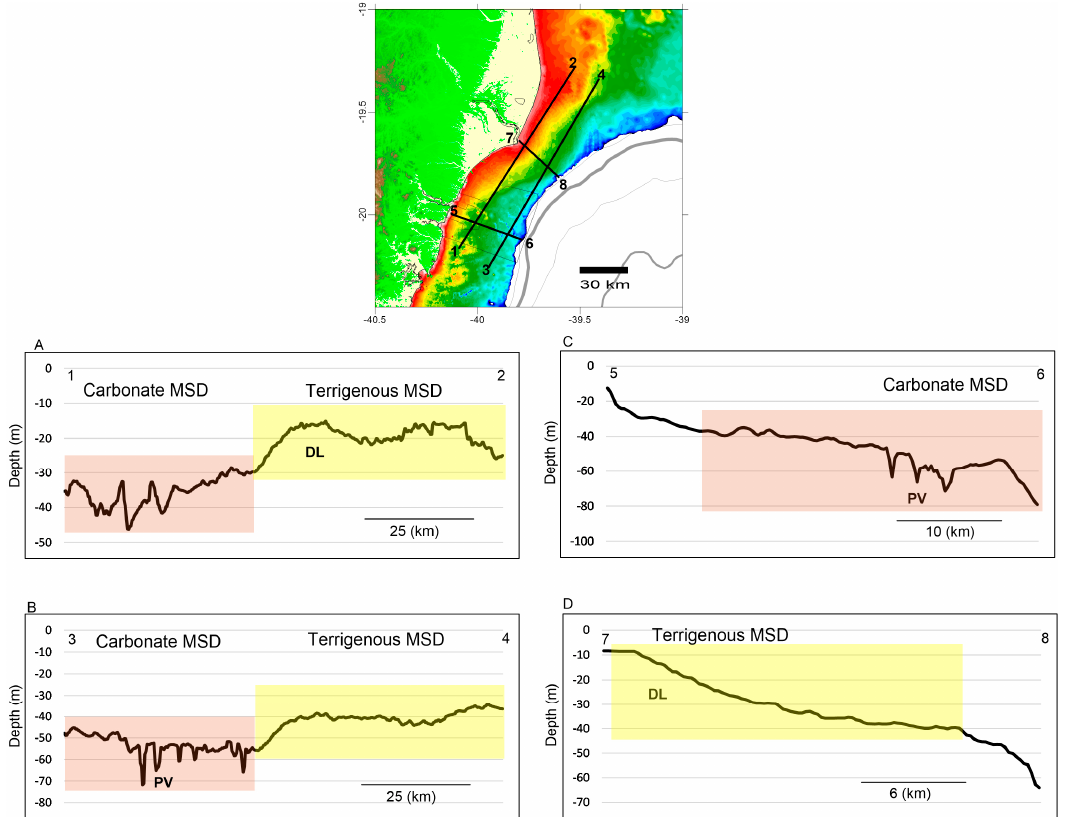
Figure 7. Long-shore and cross-shelf bathymetric profiles and associated MSD. PV—paleovalley; DL—delta front; ( A ) long-shore, inner shelf bathymetric profile showing the morphological and faciologic transition between MSDs, ( B ) long-shore, outer shelf bathymetric profile showing the morphological and faciologic transition between MSDs, ( C ) cross-shelf bathymetric profile along the Carbonate MSD, ( D ) cross-shelf bathymetric profile along the Terrigenous MSD.